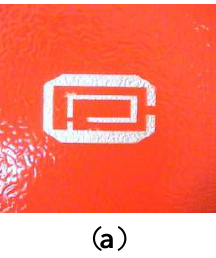
Figure 5. ( a ) The antenna printed on a car body and ( b ) printed on a can